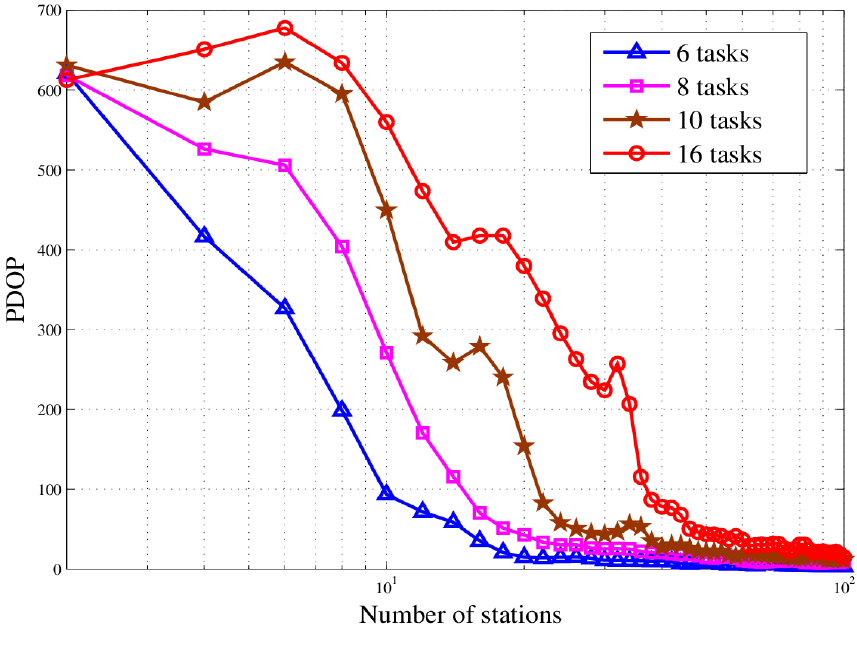
Figure 20. PDOP curve in different scenarios.